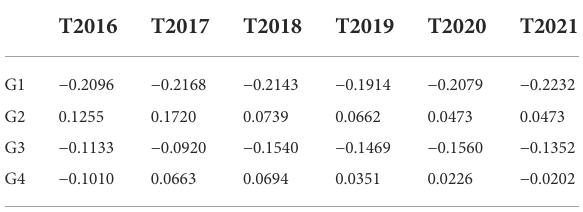
TABLE 2 Global Moran ’ s